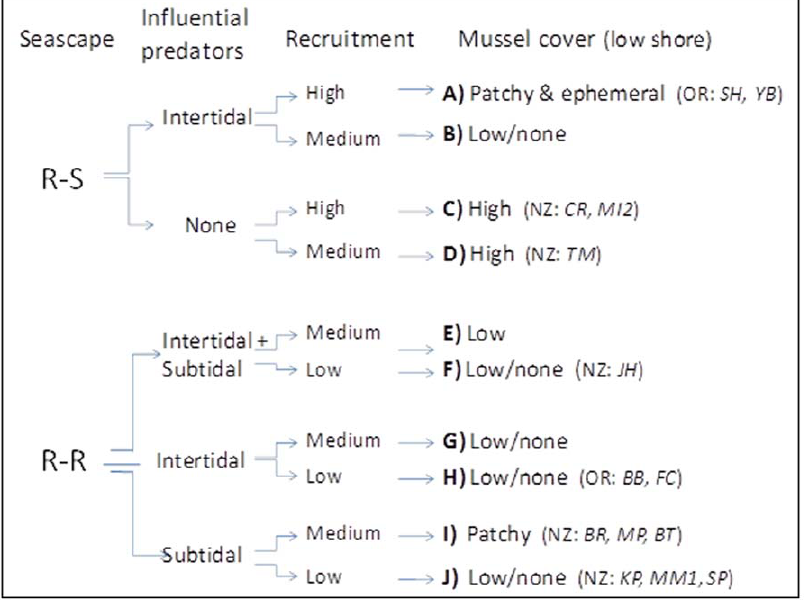
Figure 6. Conceptual model describing the influence of seascape, the presence of influential intertidal/subtidal predators (predators that have a strong influence on intertidal prey abundance) and recruitment on the distribution of mussel beds in the rocky shore in regions where mussel beds or patches are dominate features on the rocky shore (see text for explanation). The outcomes for the different scenarios are labeled alphabetically with bold capital letters. Examples of sites with the specific configuration are given in parentheses. Geographical regions: OR=Oregon (information from Menge publications and from Rilov unpublished data and personal observations), NZ=New Zealand. Site code names are from Fig. 1 and for Oregon sites as follows: SH=Strawberry Hill, YB=Yachats Beach, BB=Boiler Bay, FC=Fogarty Creek.